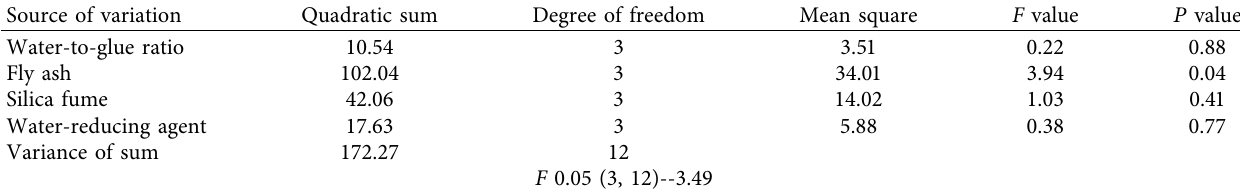
Table 6: Variance analysis of 7-day compressive strength of concrete.